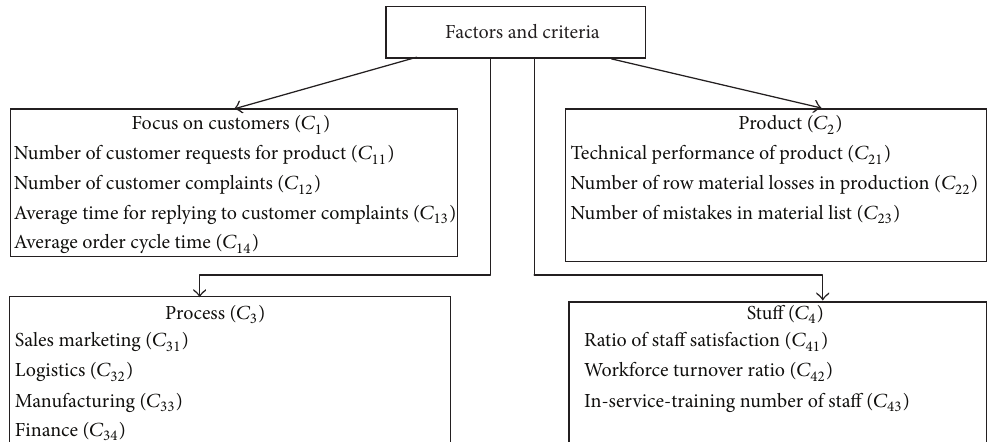
Figure 2: The factors and criteria used in SCM performance evaluating